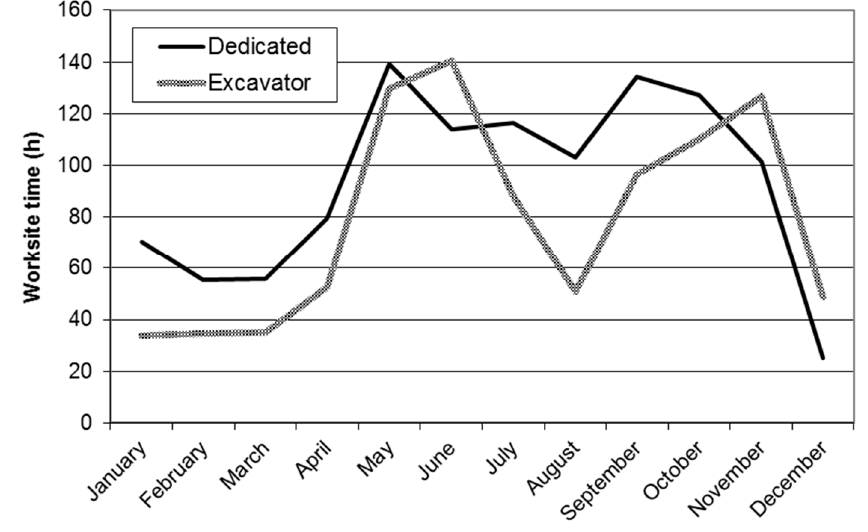
Figure 3. Total working hours per month and per machine type (mean of three samples for each type).